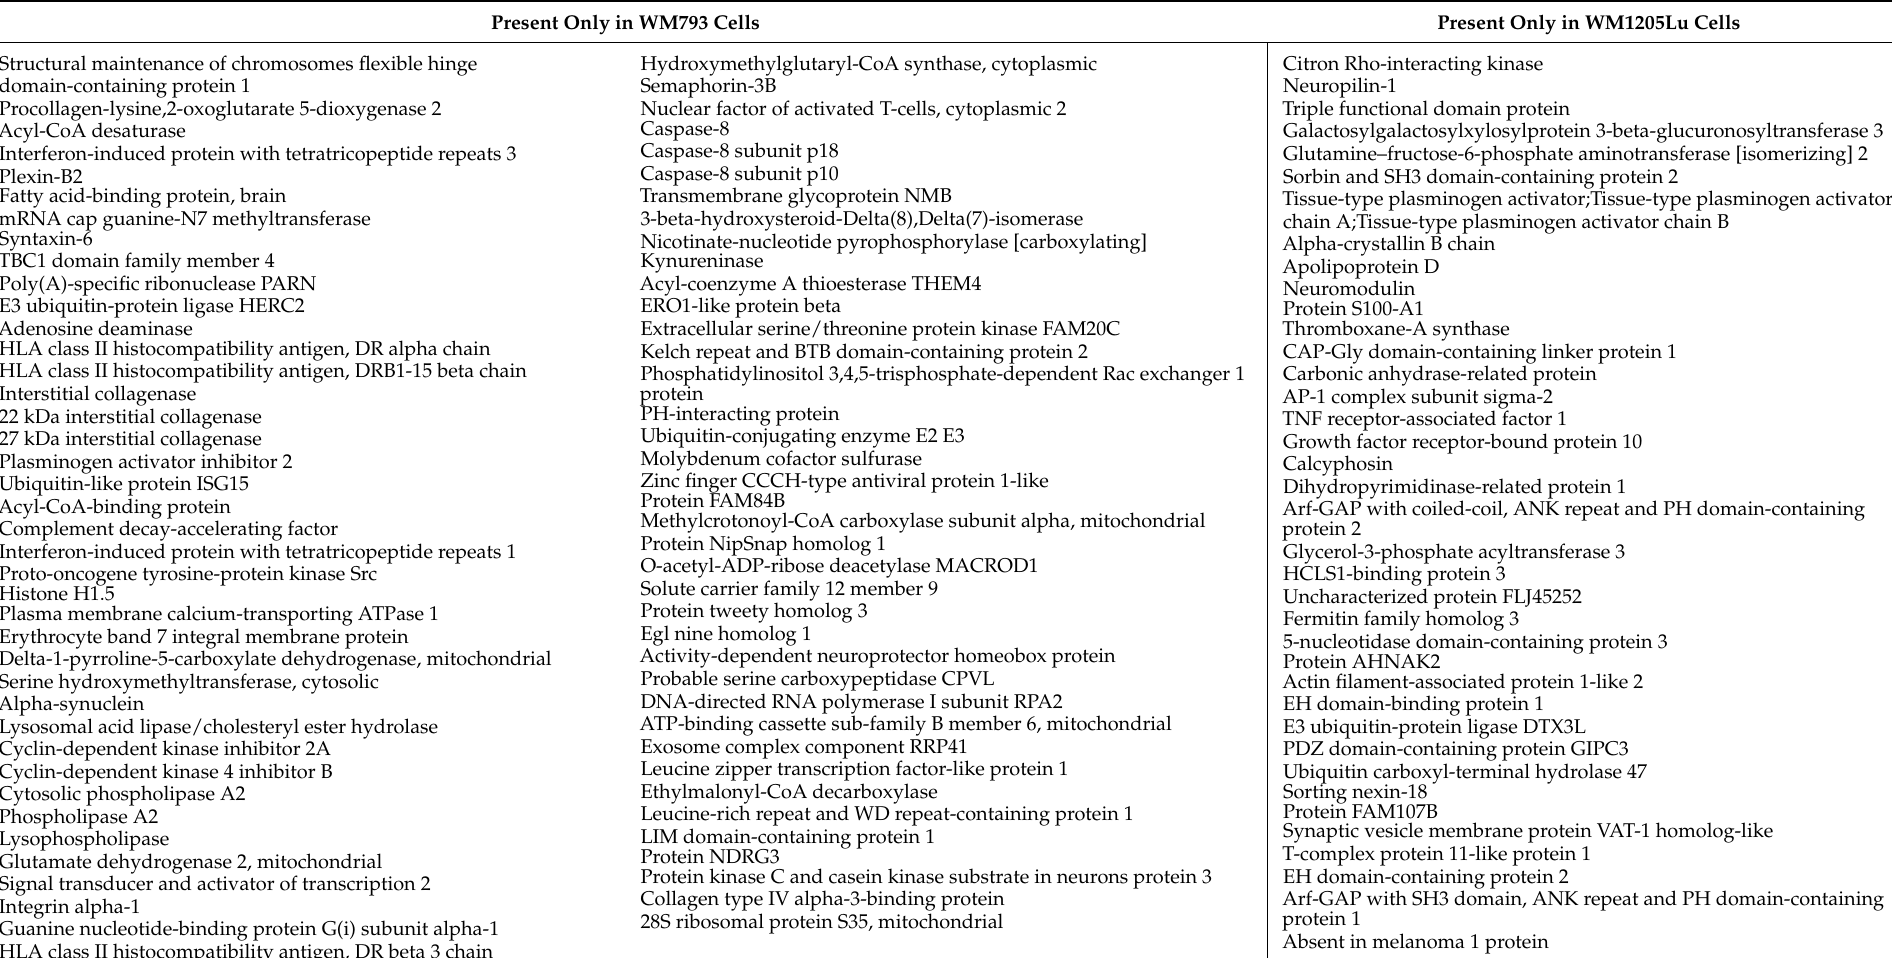
Table 1. List of proteins identified in WM793 cells but not found in any replicates of WM1205Lu cell samples and vice versa. Present Only in WM793